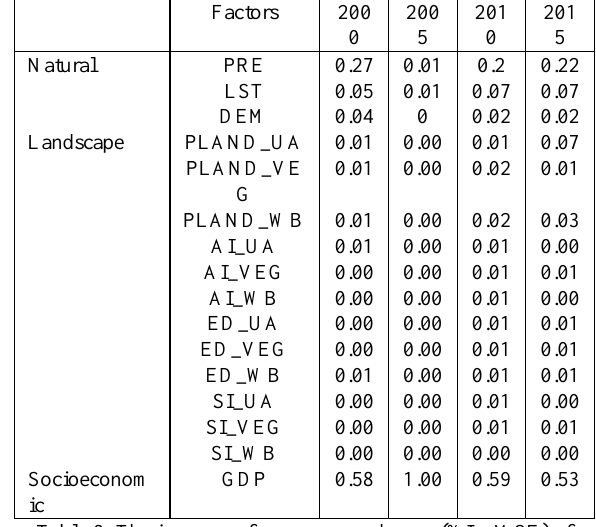
Table 8. The increase of mean squared error (%IncMSE) of natural and socioeconomic factors in (a) 2000, (b) 2005, (c) 2010 and (d)